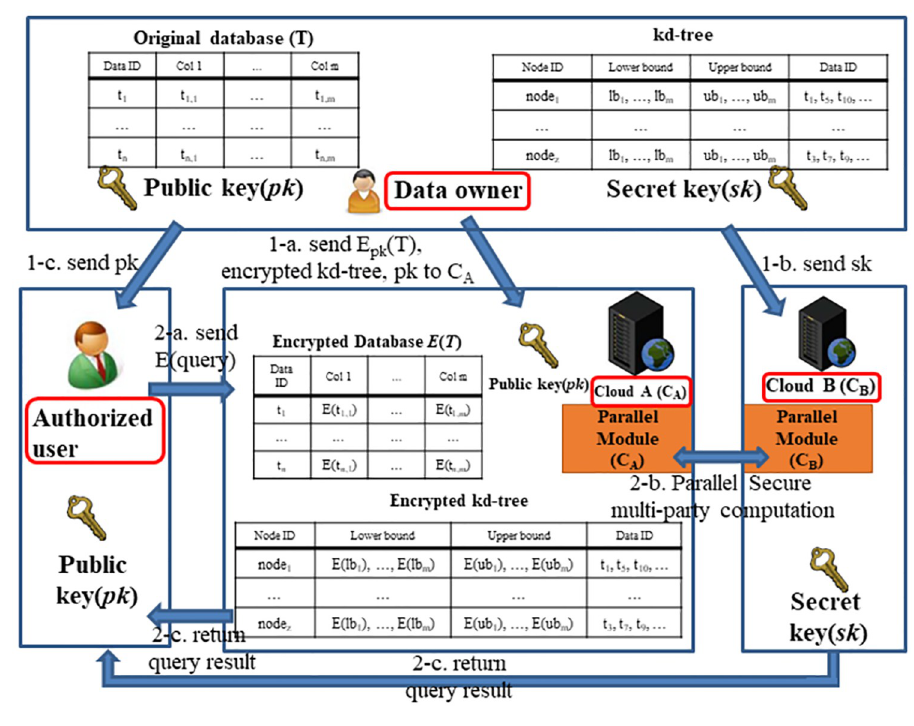
Fig 2. Overall system